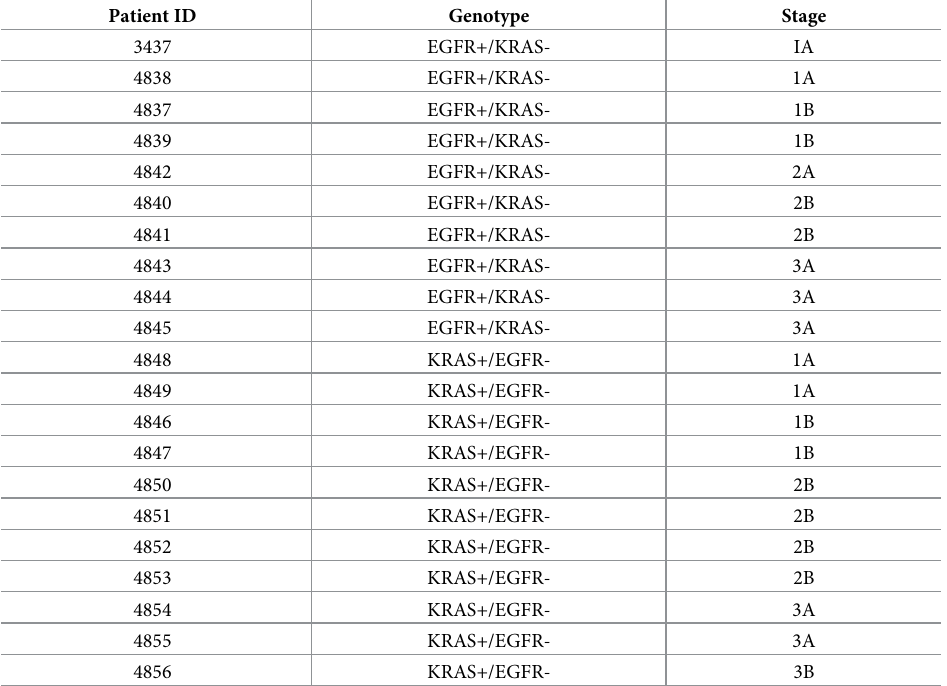
Table 7. Stage, genotype, and pathological classification of lung adenocarcinoma